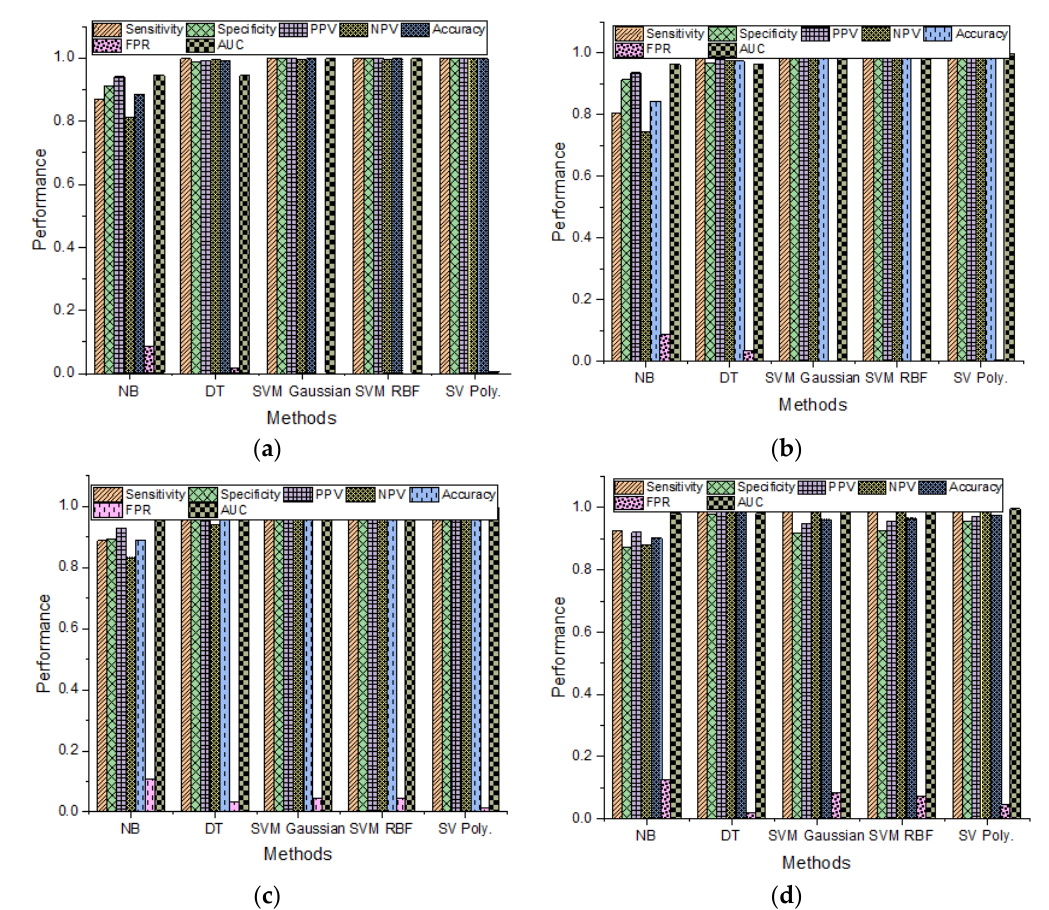
Figure 3. Detecting lung cancer based on different image enhancement methods: ( a ) texture features only, ( b ) image adjustment, ( c ) gray-level thresholding, ( d ) histogram equalization.